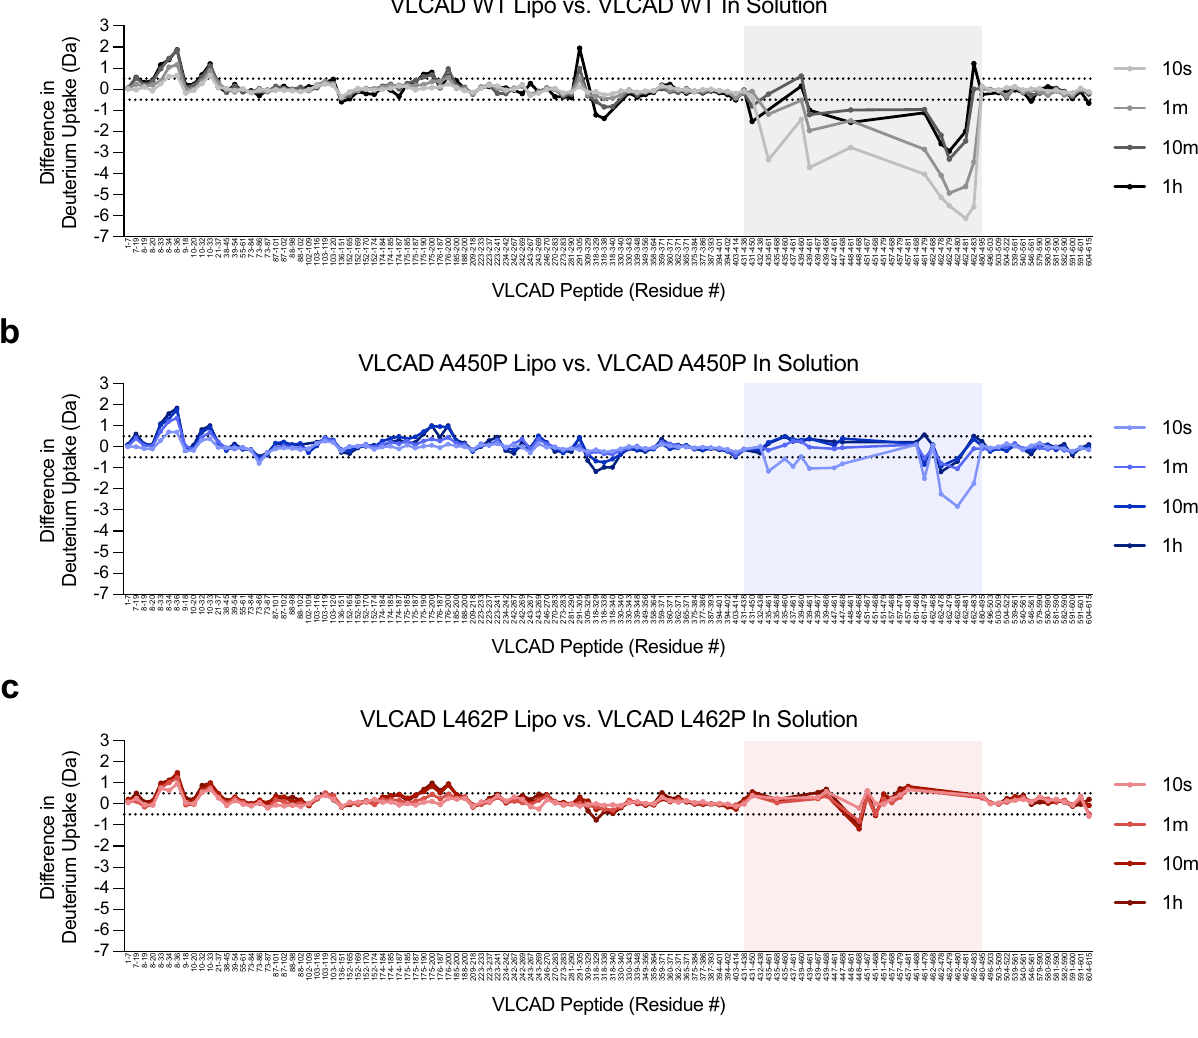
Fig. 3 HDX MS analysis of wild-type and proline-mutant VLCAD proteins in the presence and absence of liposomal membranes. a - c Deuterium difference plots showing the relative deuterium incorporation of wild-type ( a ), A450P ( b ), and L462P ( c ) VLCAD proteins in the presence of liposomes minus the relative deuterium incorporation in solution, as measured after 10 s, 1 m, 10 m, and 1 h of deuteration. Regions of deprotection and protection above 0.5 Da (dotted line) are considered meaningful. Peptides of the VLCAD C-terminal region that show protection in the presence of liposomal membrane, an effect notably impacted by proline mutagenesis, are shaded. HDX MS experiments were performed twice with independent preparations of VLCAD proteins. See Supplementary Data 1 for the HDX MS data used to create this fi